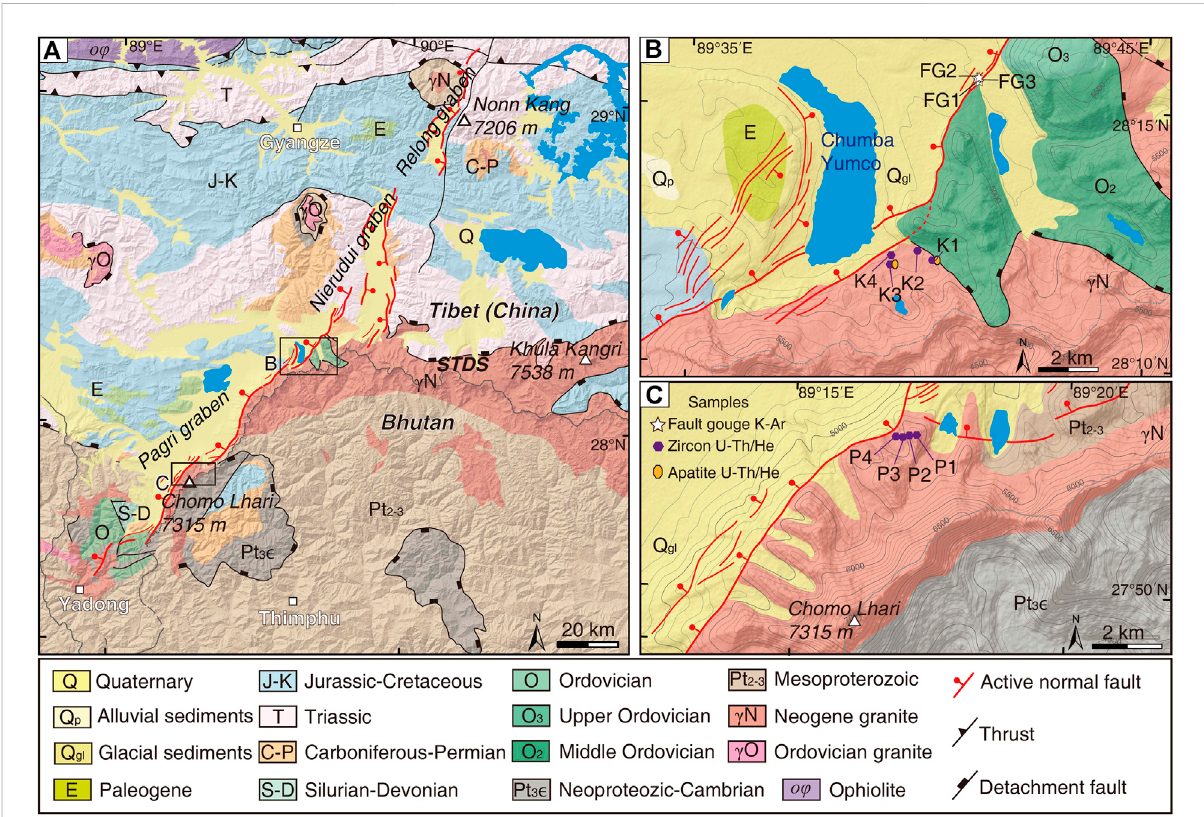
FIGURE 2 (A) Geological map of the southern YGR (location in Figure 1B) [revised from China University of Geosciences (Beijing) (CUGB), 2004]. (B) Geological map of Chumba Yumco area with sample locations (FG1 – FG3, K1 – K4) (location in A). (C) Geological map of Chomo Lhari area